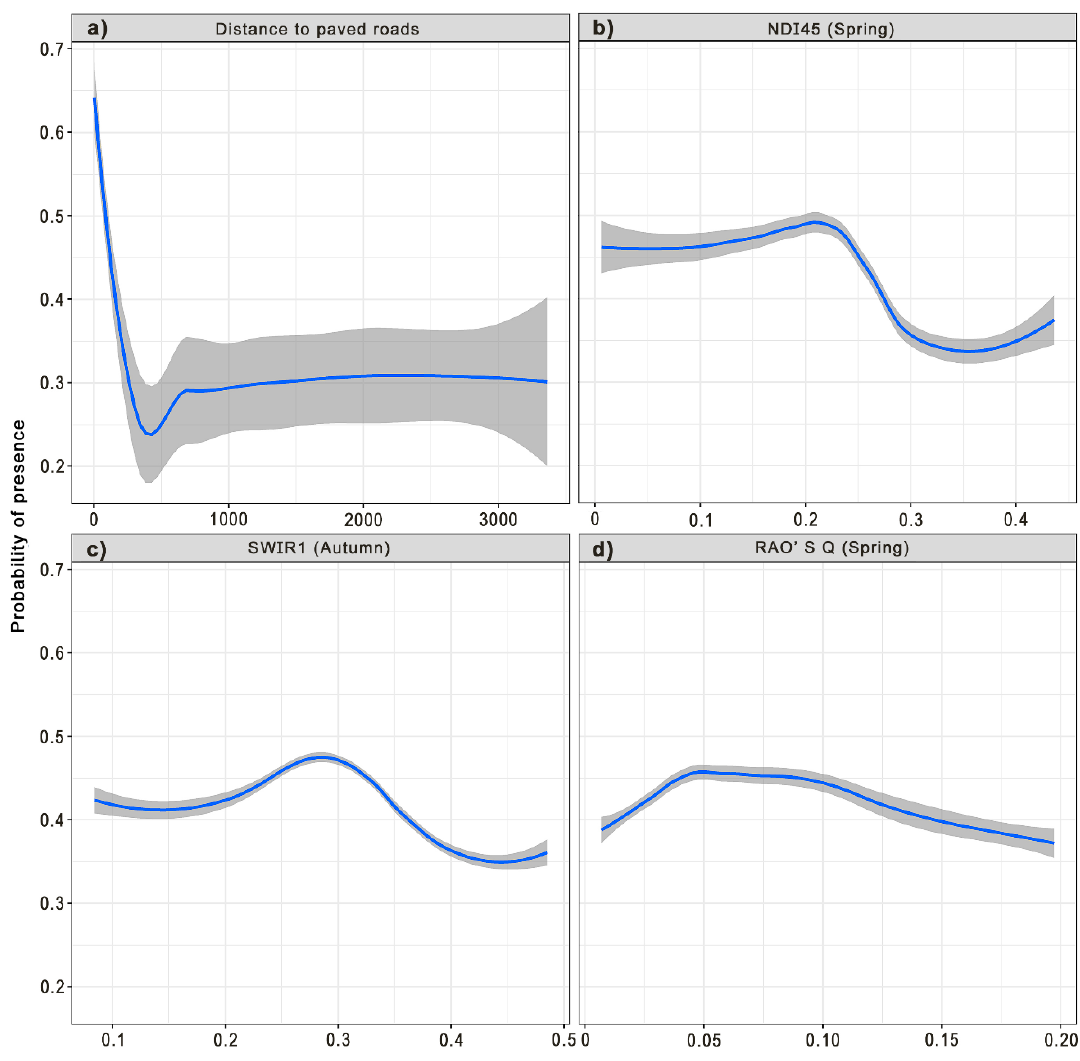
Figure 3. Interactive e ff ects (partial dependence curves) of most important variables: ( a ) “Distance to paved roads”, ( b ) “NDI45 (Spring)”, ( c ) “SWIR1 (Autumn)”, and ( d ) “RAO’s Q (Spring)”, on probability of Cabrera vole occurrence. The average 10-fold cross-validation results are depicted by the blue lines. The grey area limits ± standard error.